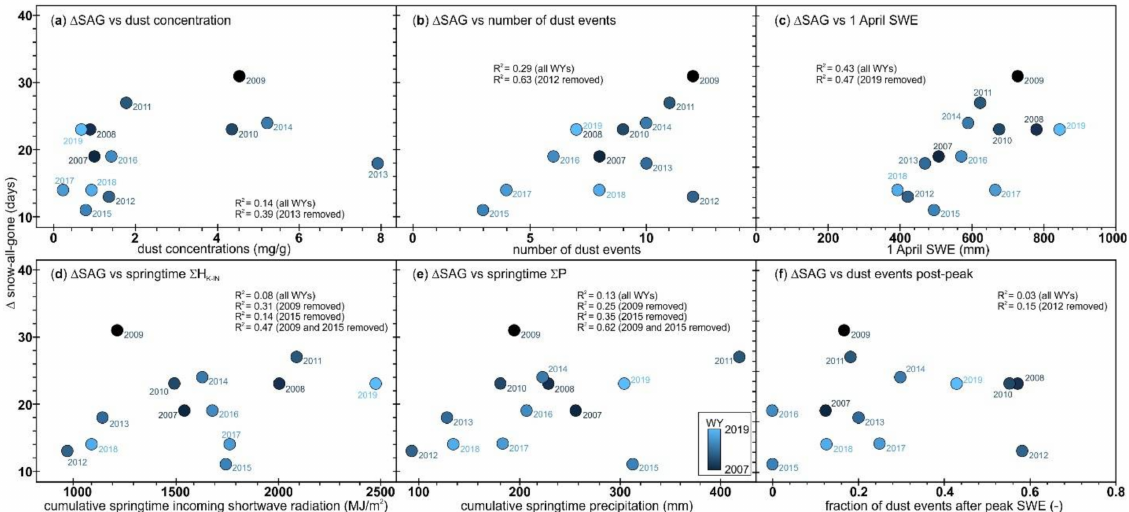
Figure 9. Comparison of snow cover duration difference in terms of modeled snow disappearance for clean vs. dust-present (actual) conditions as the change in snow-all-gone ( ∆ SAG) date, as a function of ( a ) end-of-year dust concentration, ( b ) number of dust events, ( c ) 1 April SWE, ( d ) cumulative springtime (1 April to SAG) incoming shortwave radiation, ( e ) cumulative springtime (1 April to SAG) precipitation, and ( f ) the fraction of the dust events after peak